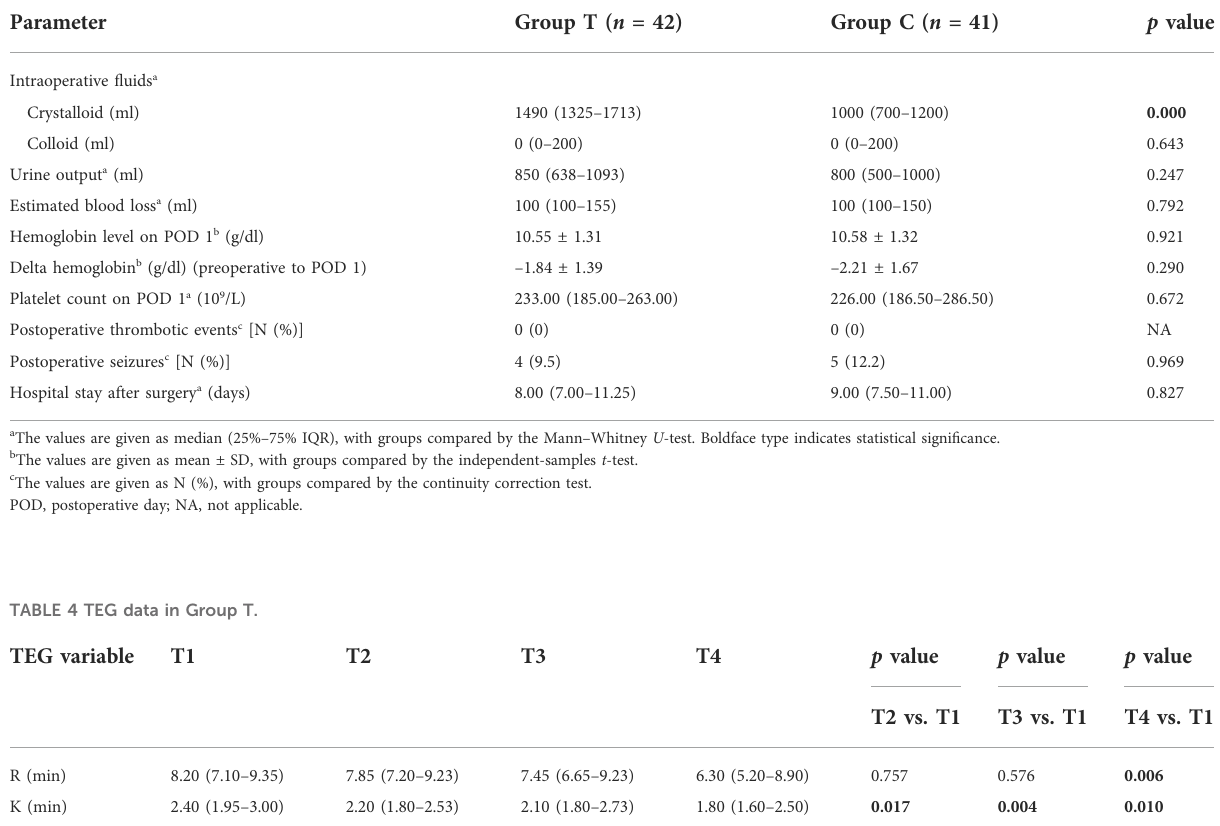
TABLE 3 Intraoperative and postoperative clinical outcomes and laboratory values in both